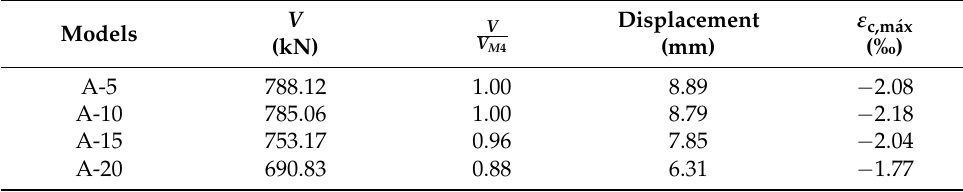
Table 3. Results obtained with Series A.